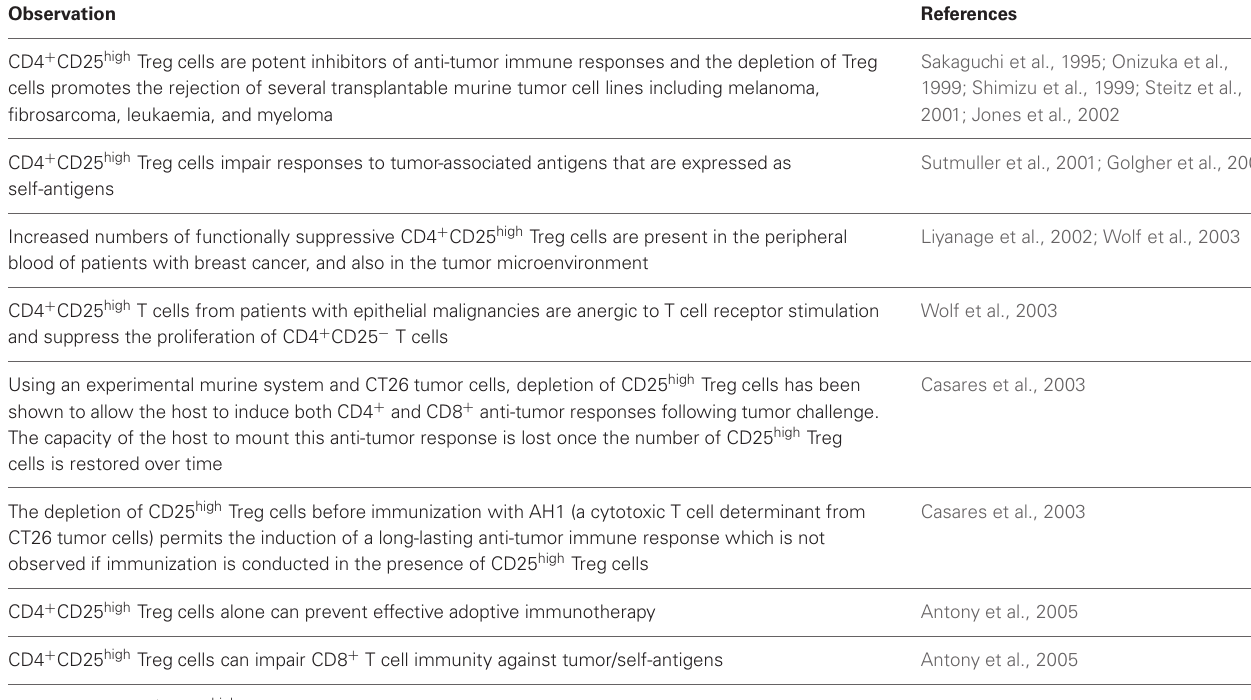
Table 1 | Influence of CD4 + CD25 high T reg cells on anti-tumor immunity.